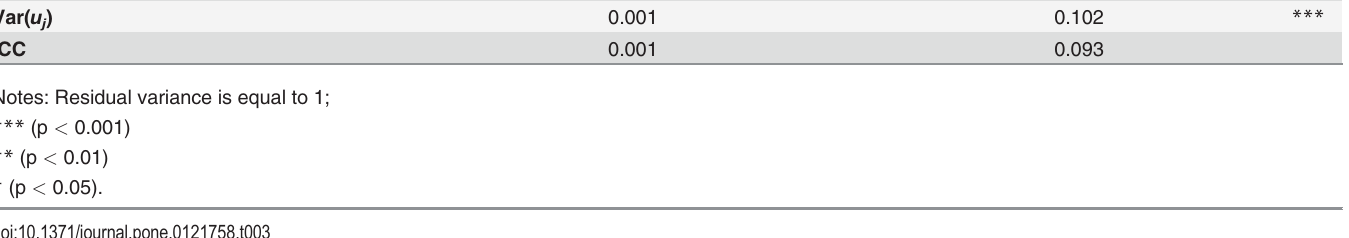
Table 4. Standard deviation of wealth measures